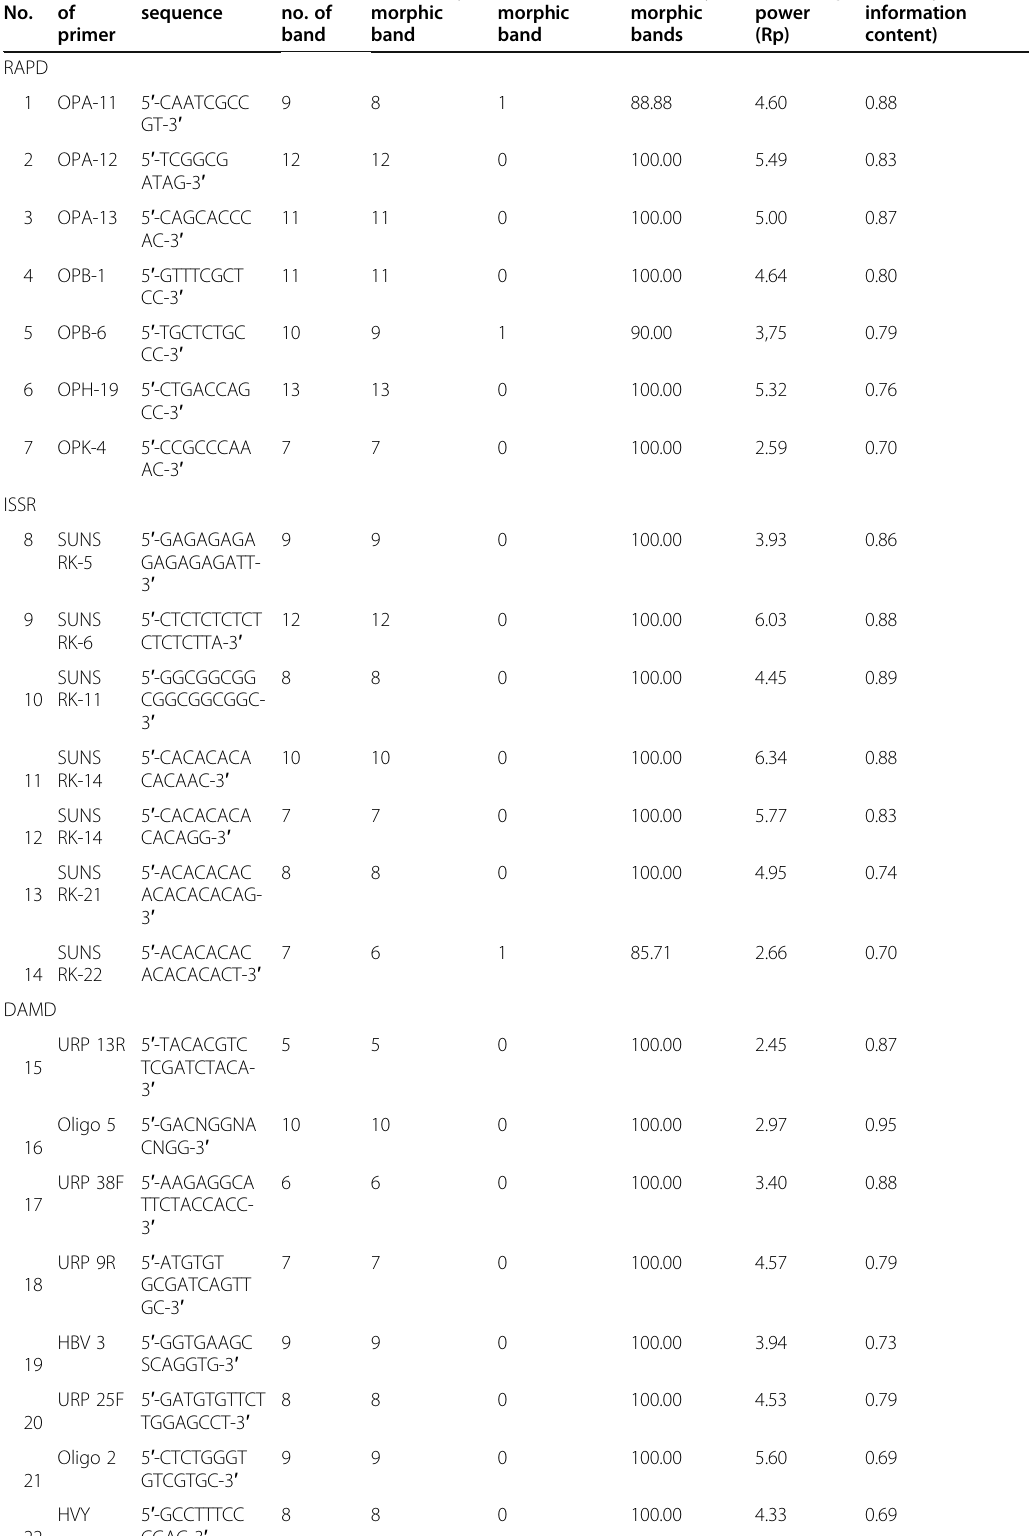
Table. 4 Extent of polymorphism as revealed by RAPD, ISSR, DAMD and SCoT primers Sl. Name No.